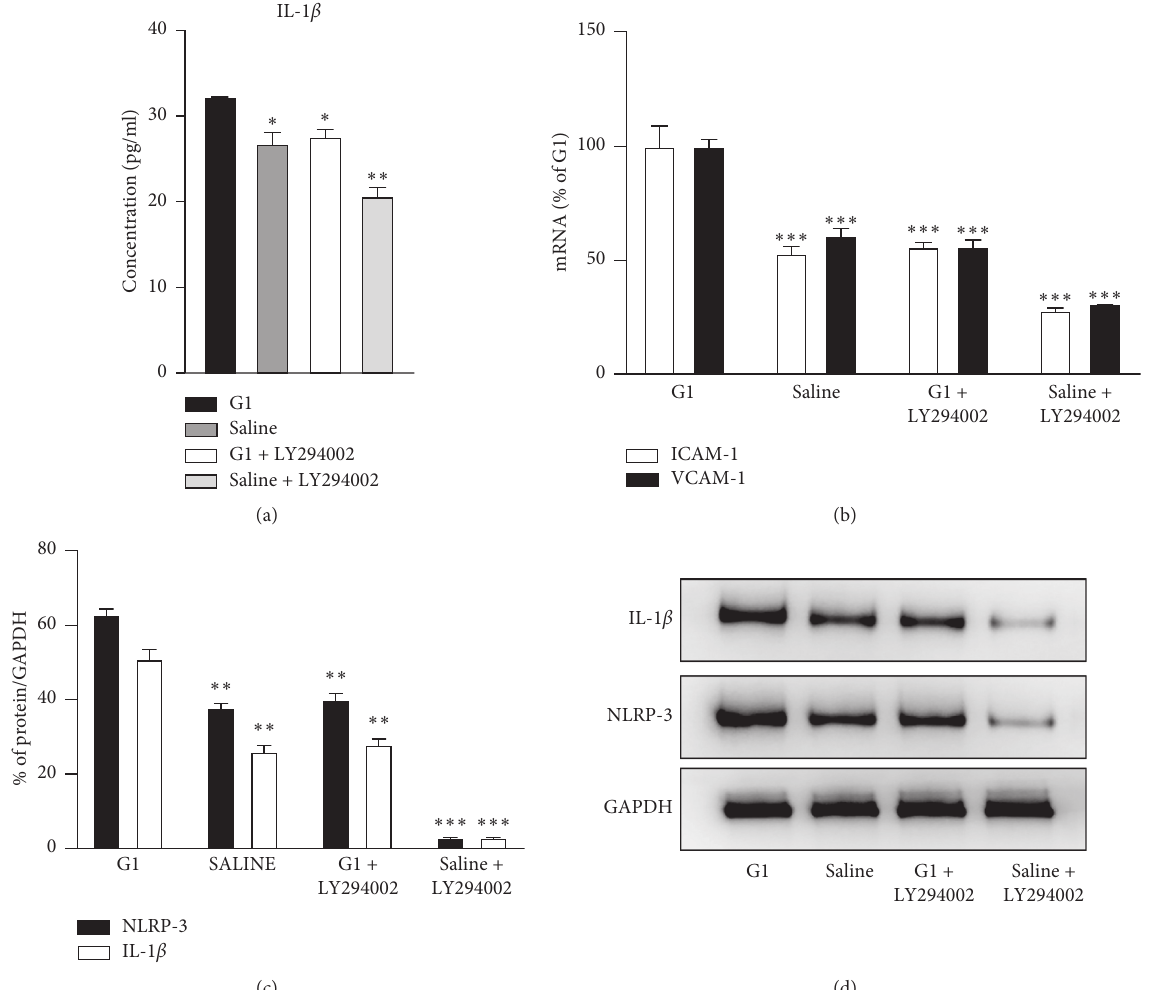
Figure 4: Inflammatory response before and after inhibition of the PI3K pathway: (a) level of cell culture medium IL-1 β ; (b) ICAM-1 and VCAM-1 mRNA expression; (c) protein level IL-1 β and NLRP-3. (d) Western blot of IL-1 β and NLRP-3. ∗∗ p value < 0.01 compared with G1, ∗∗∗ p value < 0.001 compared with